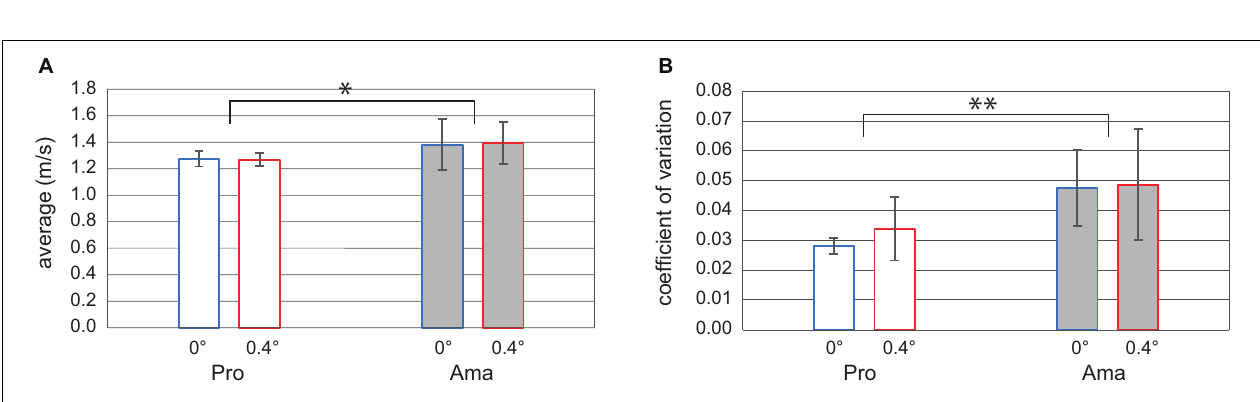
FIGURE 6 | Average alignment error in the pre-motion phase and average motion error in the motion phase. The address-aim angle (A) indicates the average of each group of values obtained by subtracting the aim angle from the address angle. The launch-address angle (B) indicates the average of each group of values obtained by subtracting the ball launch angle from the address angle. All error bars indicate ± 1SD. * p < 0.05.